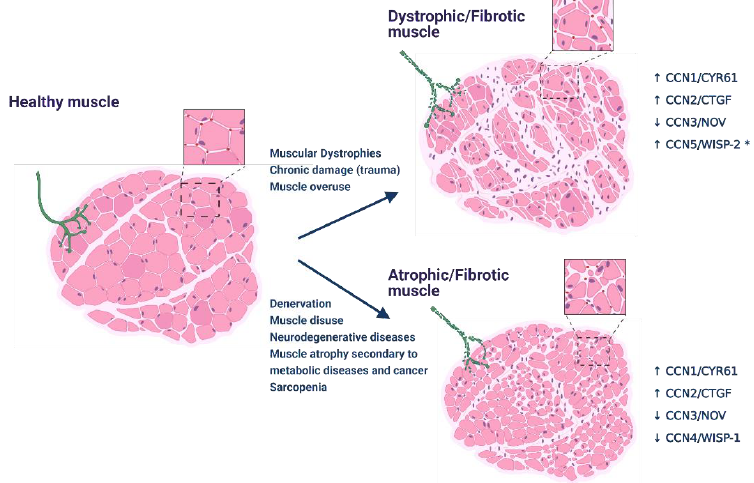
Figure 1. Pathological changes associated with neuromuscular diseases are concomitant with alter- ations in the levels of some CCNs. The healthy skeletal muscle presents myofibers of homogenous size with peripheric nuclei, accompanied by communication with motor neurons through normal neuromuscular junctions (NMJ). Muscle fibers are surrounded by regular levels of ECM, and few interstitial cells. Surrounding each fiber, capillaries assure the availability of nutrients and oxygen (inset, red dots). We classified different muscle pathologies into two groups schematized on the right. The picture on top shows significant heterogeneity in the size of myofibers and centrally located nuclei due to consecutive rounds of degeneration/regeneration. There is an increased number of interstitial cells, corresponding to cells from the immune system and myofibroblasts that contribute to the excessive accumulation of ECM proteins. Capillary density is lower, which limits oxygen availability. Generally, the NMJ is also compromised. These characteristics are present in muscular dystrophies, muscle overuse, and chronic muscle damage. At the bottom, the whole muscle and myofibers are smaller, and motor neurons and NMJ are significantly affected. There is an increment in the number of interstitial cells, significantly increased ECM accumulation, and reduced capillary density. These features are frequent in muscle atrophy due to neurodegenerative diseases, denervation, disuse, metabolic diseases, cachexia, and sarcopenia. CCNs alterations in these two groups of skeletal muscle diseases are indicated. Up and down arrows indicate up- and down regulation, respectively, at mRNA and/or protein levels (* extrapolated from cardiac muscle disease). Figure created with BioRender.com (accessed on May 14 th , 2021).